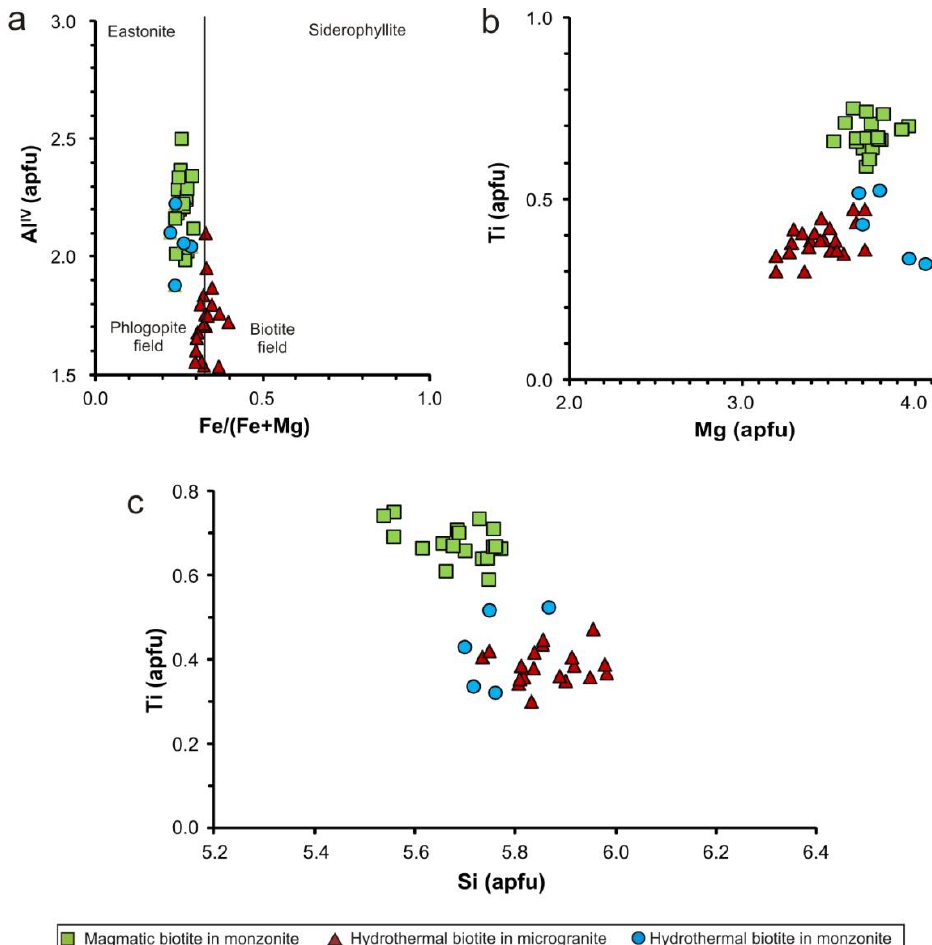
Figure 6. ( a ) Fe/(Fe + MgO) versus Al IV diagram (after [43]), ( b ) Mg apfu versus Ti apfu diagram and ( c ) Si apfu versus Ti apfu diagram of the magmatic and hydrothermal biotite at the Maronia porphyry system. apfu, atoms per formula unit.